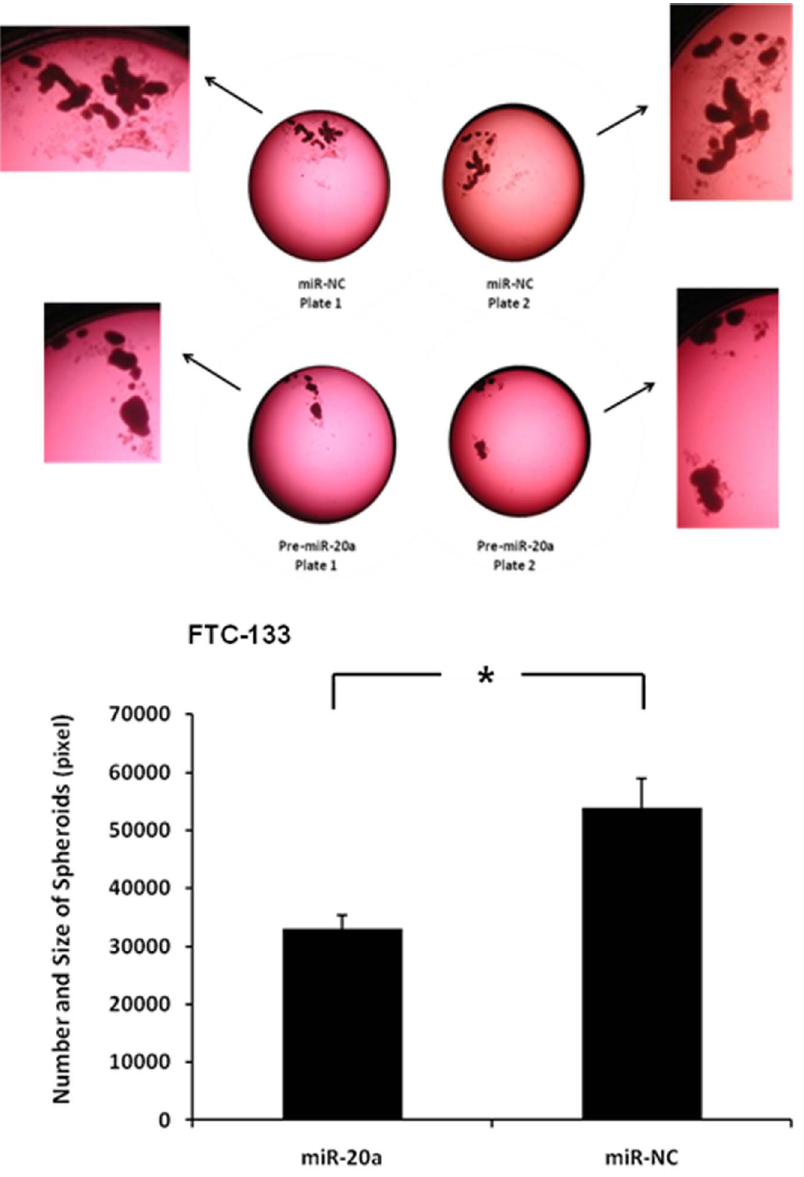
Figure 3. MiR-20a overexpression decreases tumor spheroids. ( A ) Representative image of spheroids in culture with miR-20a overexpression. ( B ) Quantification of spheroid difference with miR-20a overexpression. The total area occupied by the spheroids within an image was measured by circumscribing the perimeter of each spheroid, marking the entire area, and calculating the pixel numbers with ImageJ software (Maryland, USA). The Y axis represents the size and number of the spheroids. Error bars represent SEM (* indicates p , 0.05).